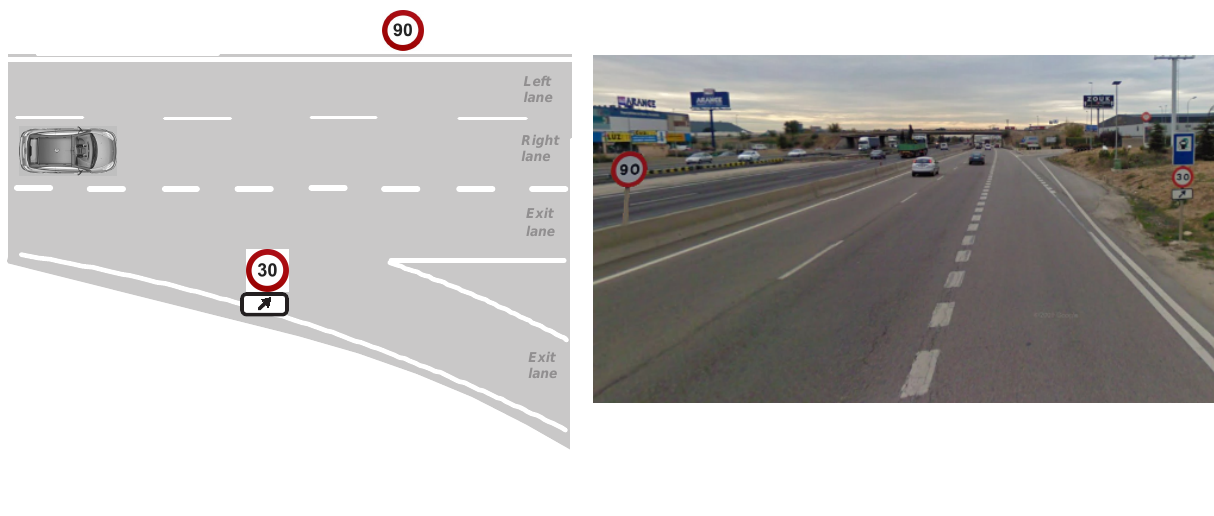
Figure 12. ( Left ) conflict scenario with two different speed signs; ( Right ) sample image.